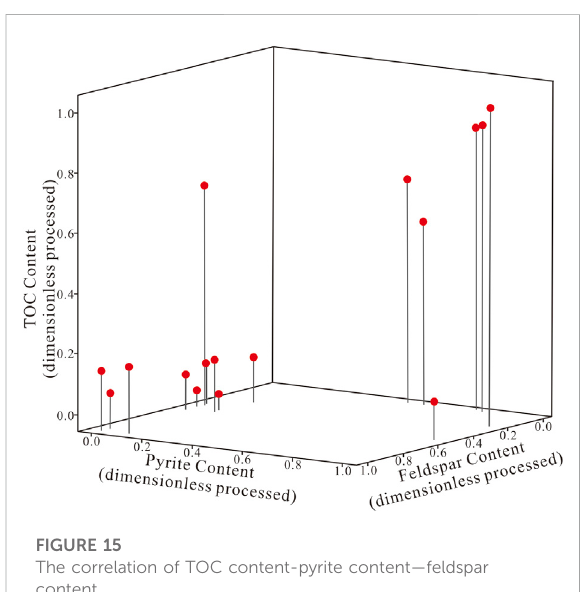
FIGURE 15 The correlation of TOC content-pyrite content — feldspar